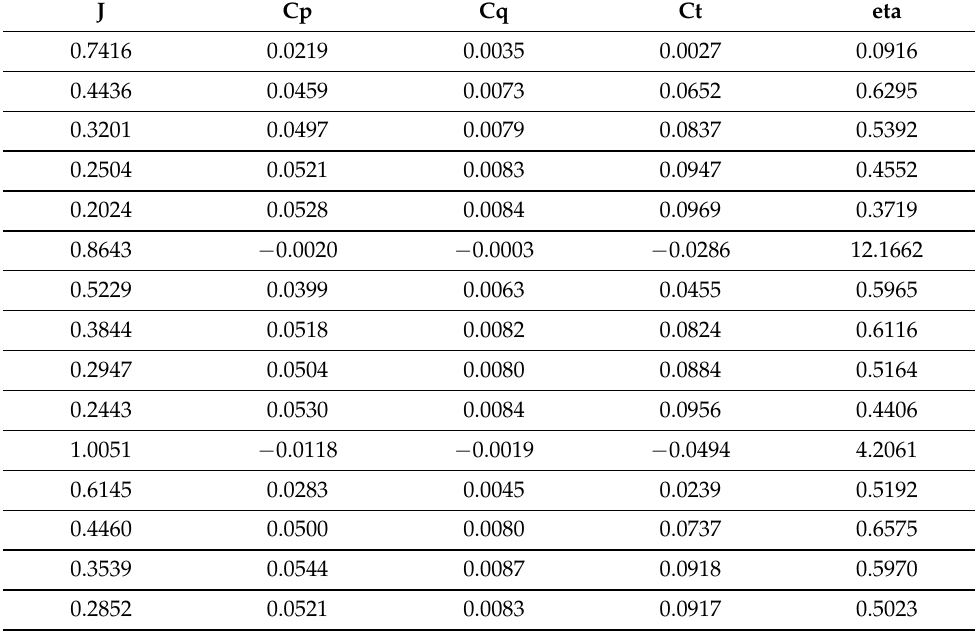
Table A9. APC 16 × 12 propeller wind tunnel processed